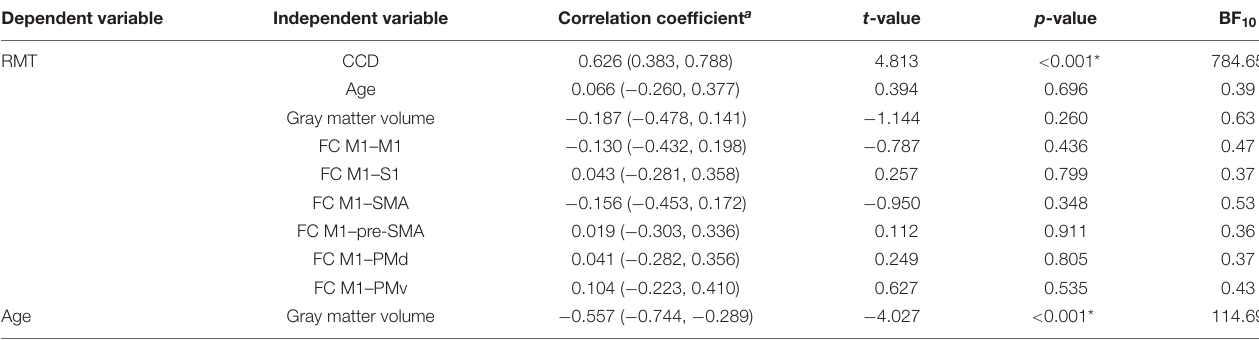
TABLE 1 | Correlation coefficients for the dominant hemisphere.